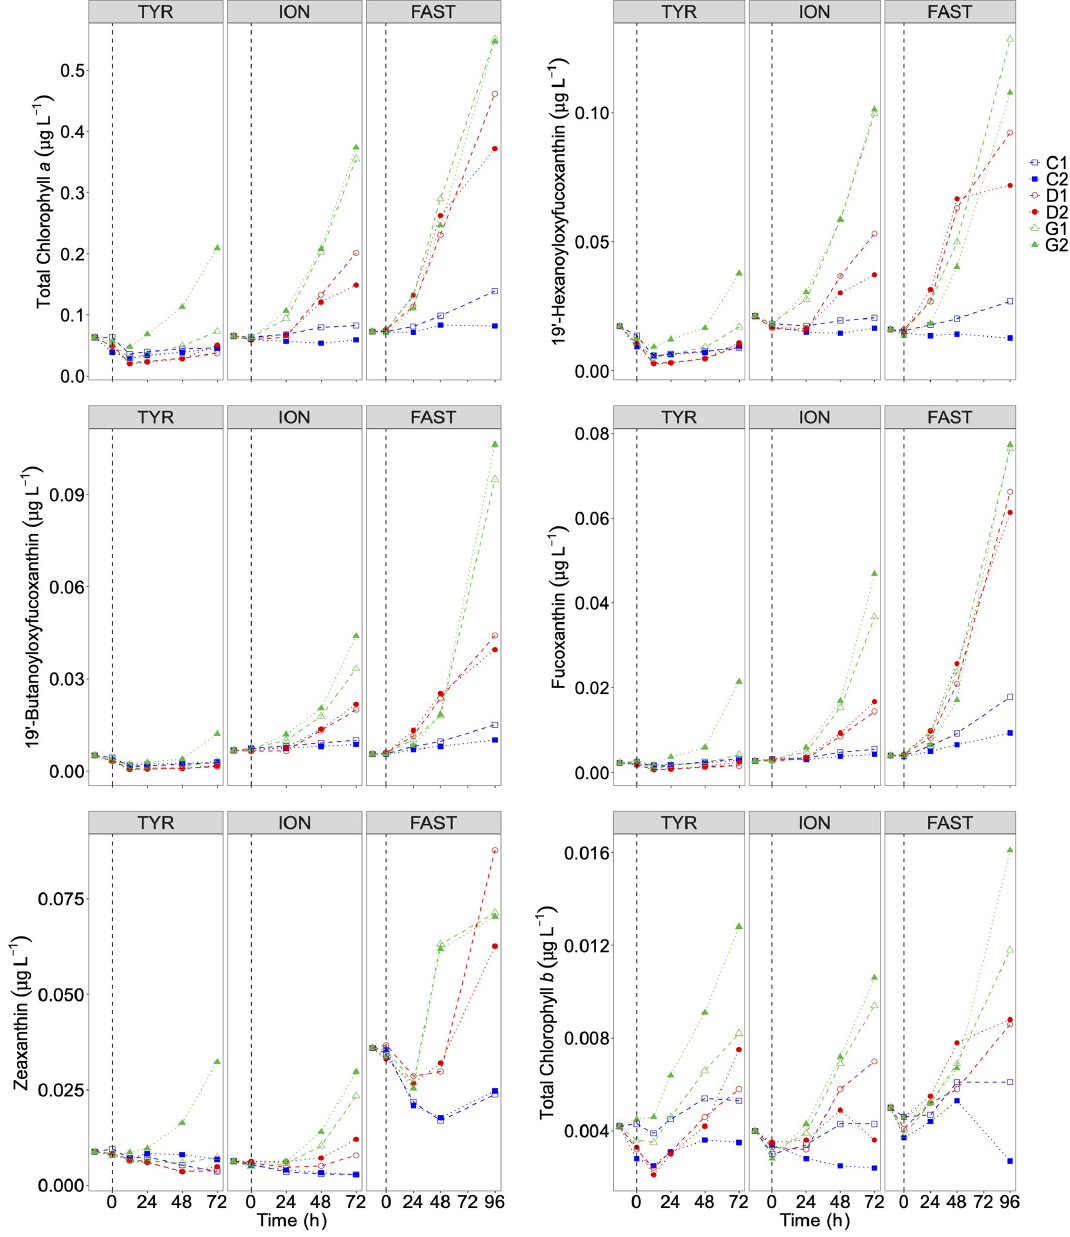
Figure 7. Total chlorophyll a and major pigments, from high-performance liquid chromatography (HPLC) measurements, in each tank during the experiments at TYR, ION and FAST. The dashed vertical line indicates the time of seeding (after